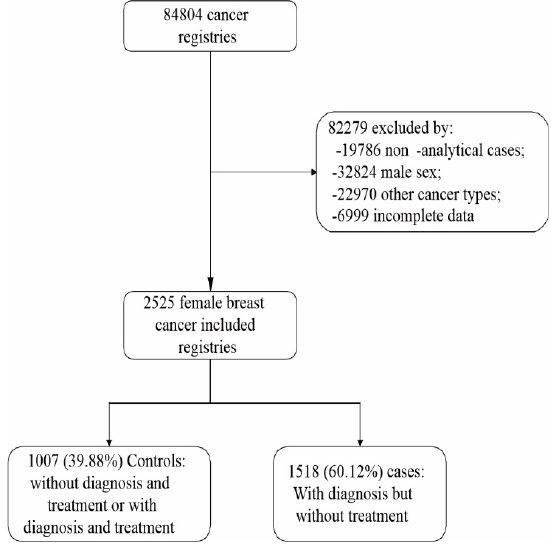
Figure 1. Flowchart for selecting the data included in this study. When analyzing the factors associated with the cases of women who arrived at the service with diagnosis and without treatment, age in the younger groups (18–39 years and 40–49 years, p = 0.001), not being white ( p < 0.001), having higher levels of education (high school and higher education) ( p = 0.003), residing in the North and Northeast regions ( p < 0.001) and late diagnosis (stages III and IV) ( p = 0.001) (Table 1) were observed as determinants. Table 1. Univariate analysis of the factors associated with lack of access to treatment in diagnosed women.